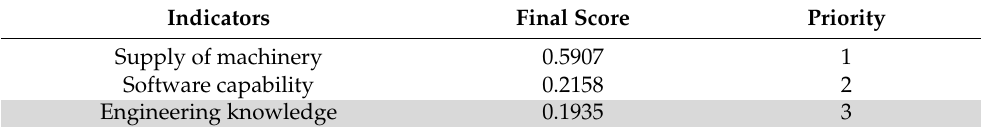
Table 10. Priority related to technical indicators.